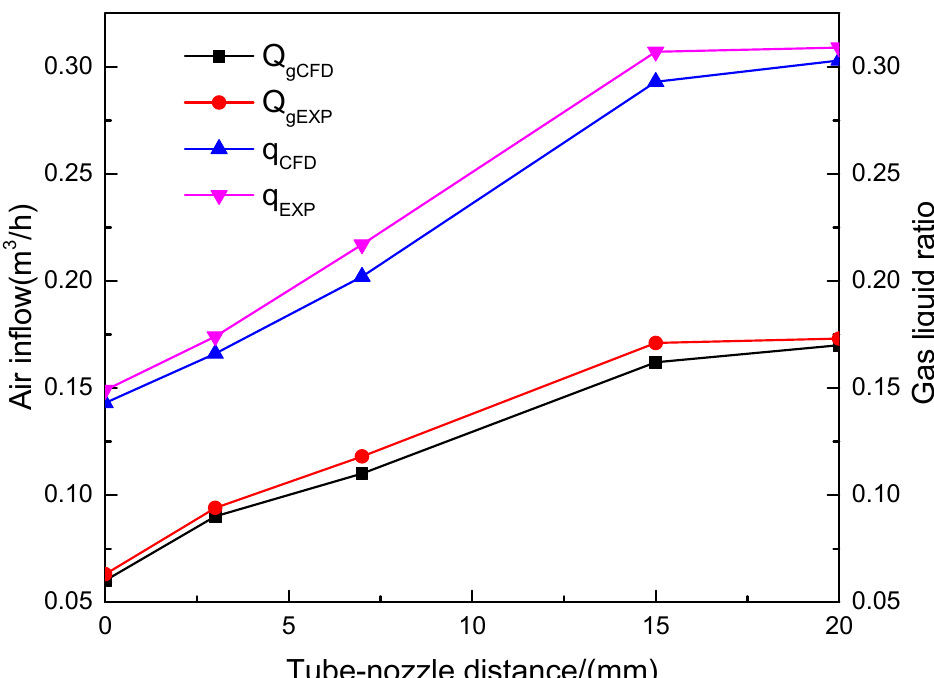
Figure 4. Comparison of numerical model and experiment.